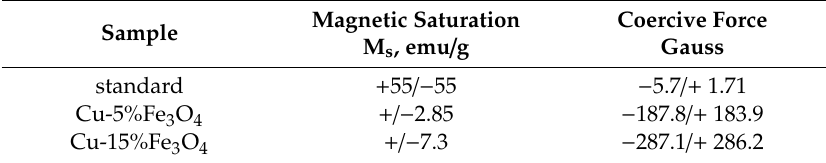
Table 6. Magnetic saturation levels and coercivity of the composite samples.